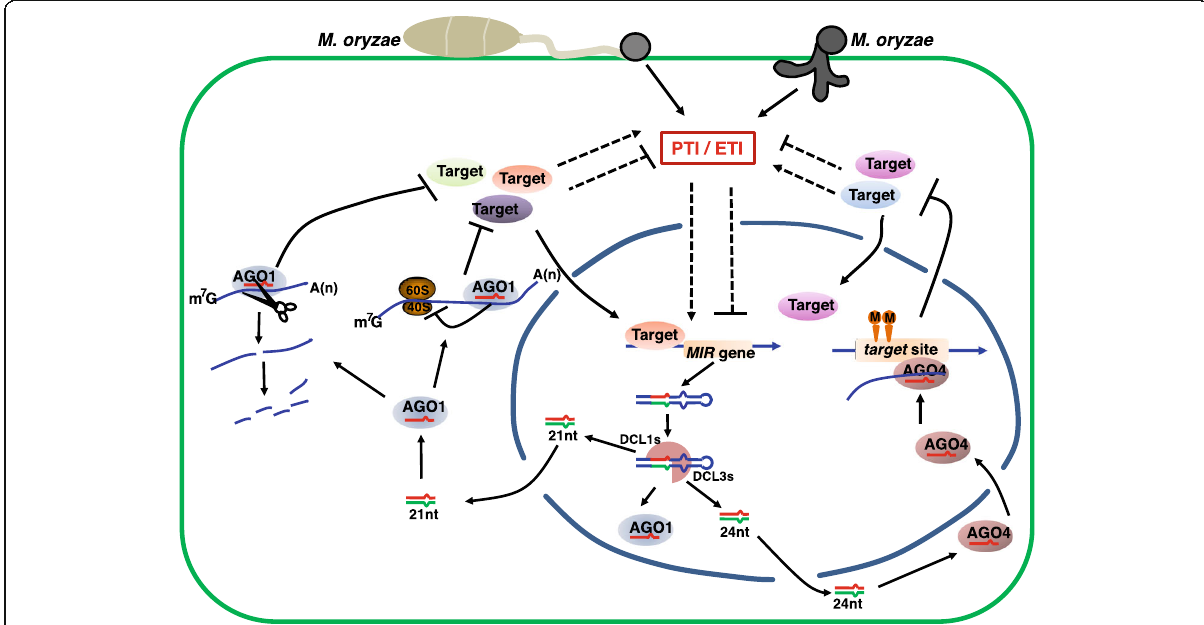
Fig. 1 Hypothetical microRNA-mediated feedback regulation of rice immunity against Magnaporthe oryzae. Infection by M. oryzae activates pathogen- associated molecular pattern- (PAMP-) triggered immunity (PTI) and/ or effector-triggered immunity (ETI). During PTI/ETI, a subset of miRNA genes ( MIR s) can be induced or suppressed, depending on their roles as positive or negative regulators, respectively. The MIR s are transcribed and processed by the RNase III family endoribonucleases such as Dicer-like1s (DCL1s) and DCL3s. While DCL3s mainly produce 24-nt (nucleotide) miRNAs, DCL1s produce 21-nt miRNAs. After modification by a series of regulators, the mature single strand 21-nt and 24-nt miRNAs are loaded into ARGONAUTE1 (AGO1) and ARGONAUTE 4 (AGO4), respectively, forming miRNA-induced gene silence complex (miRISCs). The miRISC could then hypothetically mount feedback regulation on PTI/ETI at several layers. First, the 24-nt-AGO4 miRISC re-enters the nucleus to mediate methylation of the DNA sequences complementary to the 24-nt miRNAs, resulting in transcriptional gene silencing of target genes that act in the regulation of PTI/ETI. Second, the 21-nt-AGO1 miRISC mediates the cleavage or translational inhibition of the target mRNAs, leading to post-transcriptional gene silencing of target genes that act in the regulation of PTI/ETI. Third, some target genes of miRNAs are transcription factors that can regulate the transcription of MIR genes and/or genes acting in the regulation of PTI/ETI, forming feedback regulatory